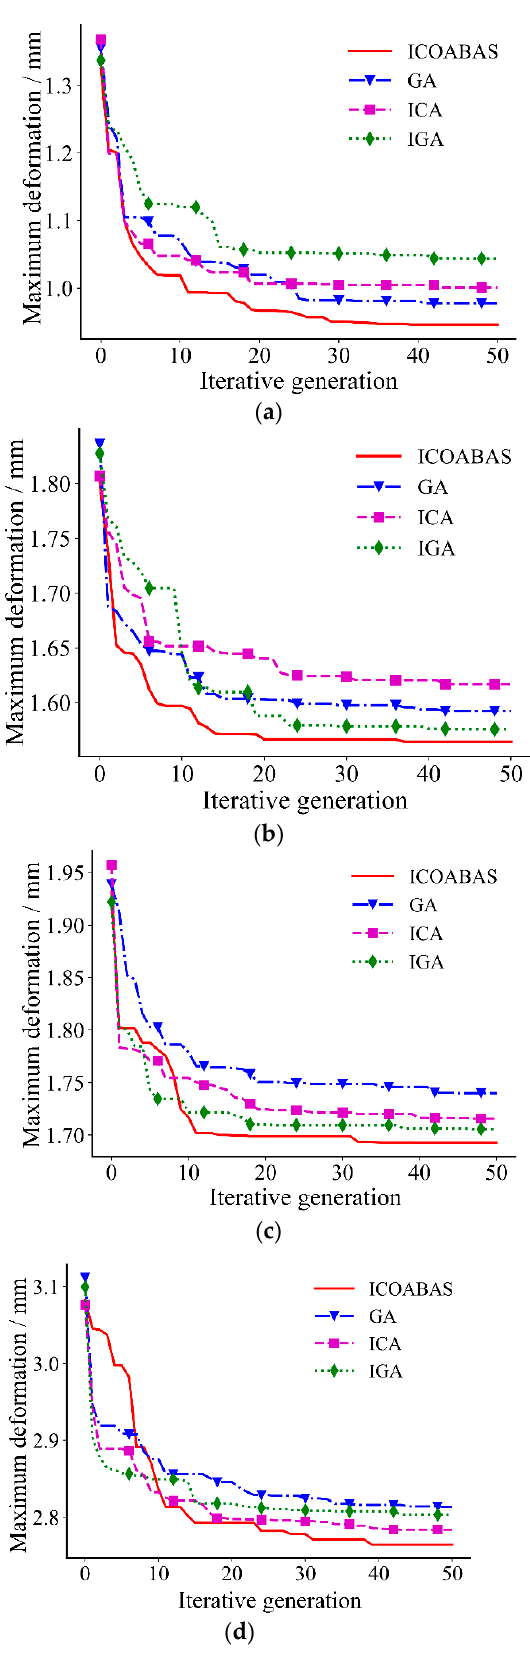
Figure 7. Evolution curves of maximum deformation from four algorithms in four structures: ( a ) welded structure 1; ( b ) welded structure 2; ( c ) welded structure 3; ( d ) welded structure 4.